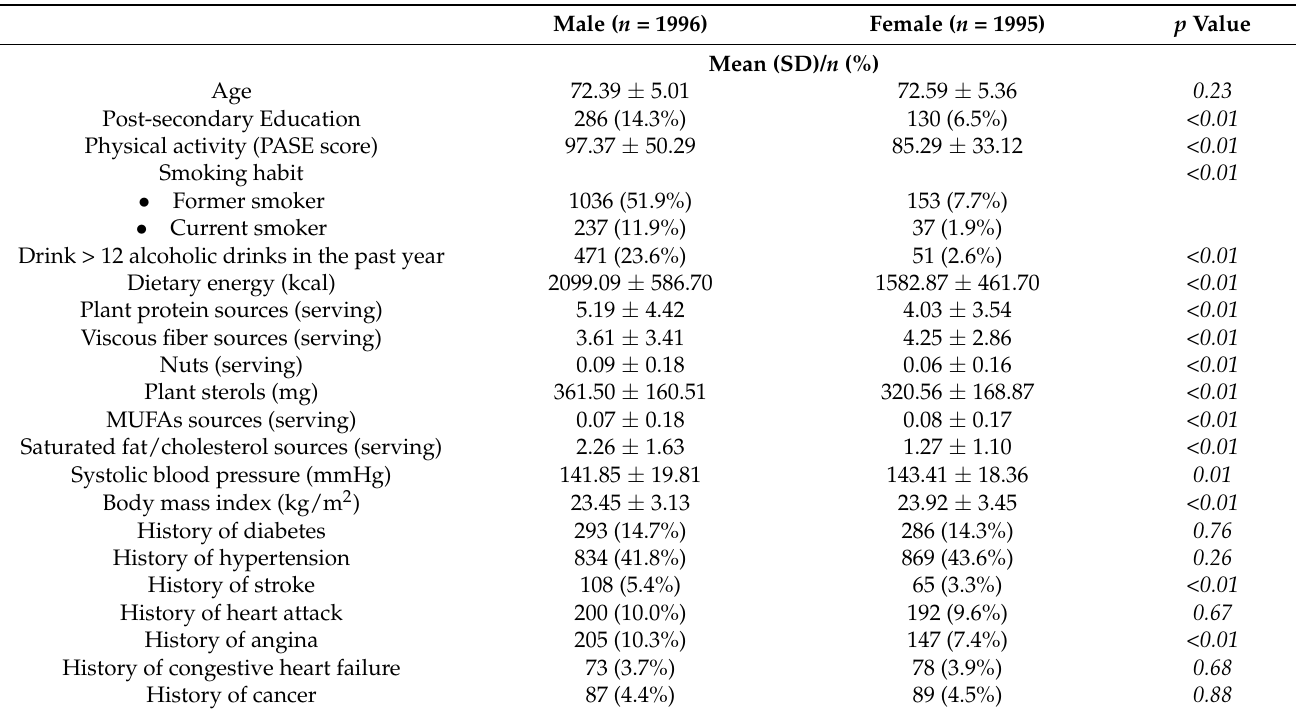
Table 1. Baseline characteristics of participants in Mr. Osteoporosis (OS) and Ms. OS Study. Male ( n =